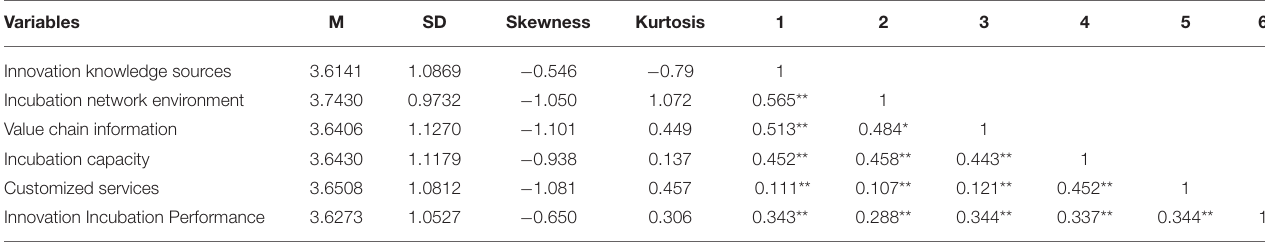
TABLE 1 | Summary table of descriptive